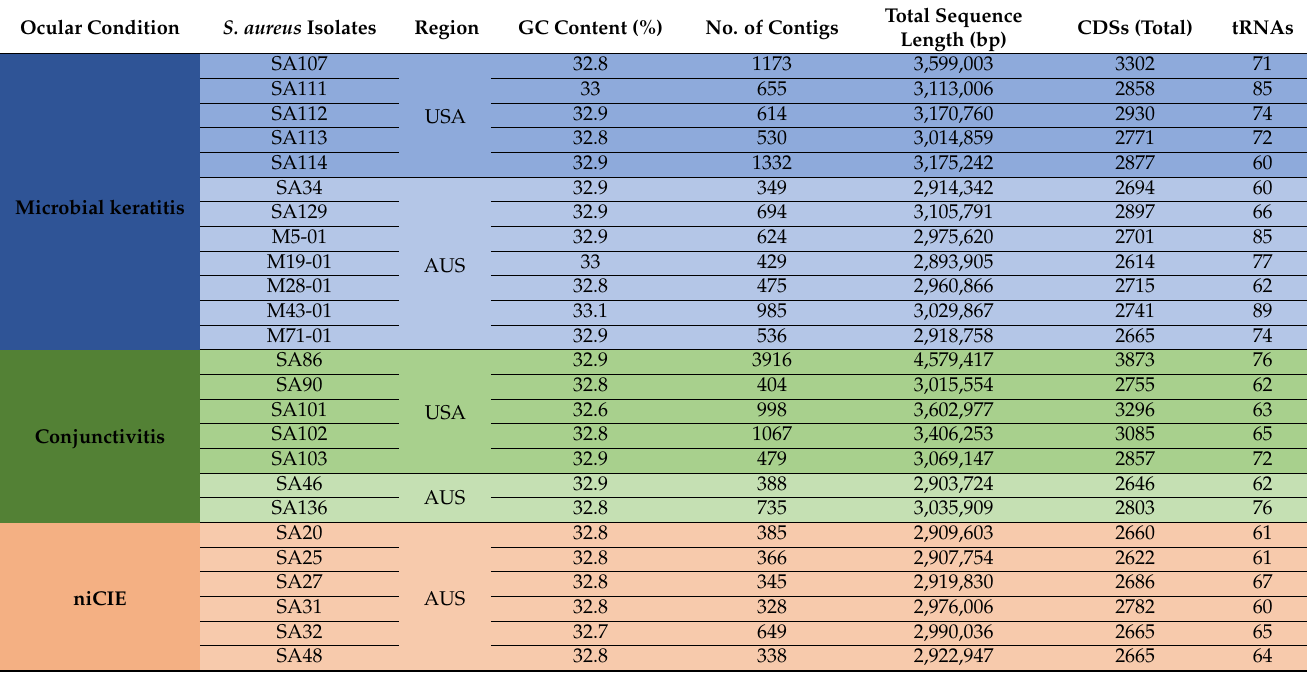
Table 1. Genetic features of the S. aureus